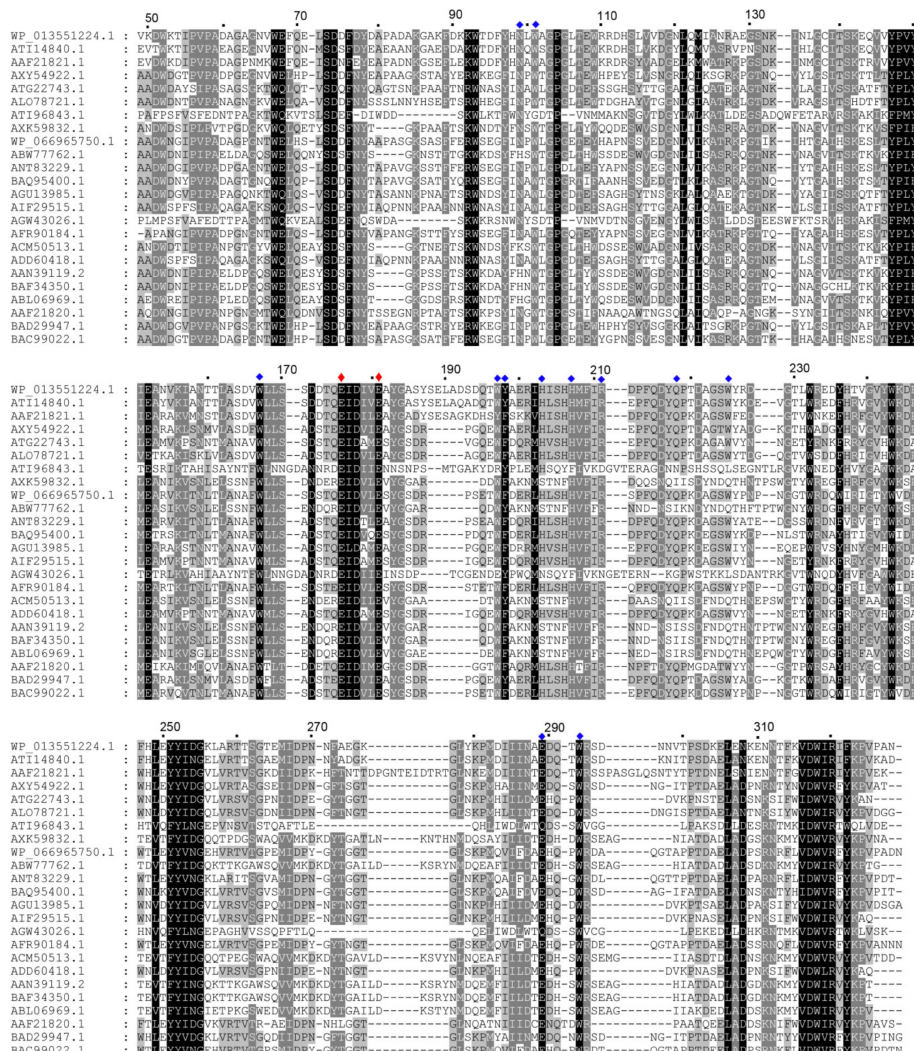
Figure 1. Multiple sequence alignment of GH16 domains of the characterized β -agarases. The alignment of amino acid sequences was carried out using Clustal Omega. The conserved and semi-conserved amino acids are shown in black and gray backgrounds, respectively. The amino acid numbering refers to the sequence of Ca Aga1. GenBank accession numbers—WP_013551224.1 for Ca Aga1 from Cellulophaga algicola DSM 14237, ATI14840.1 for Aga2 from Cellulophaga omnivescoria W5C, AAF21821.1 for Zg AgaB from Zobellia galactanivorans , AXY54922.1 for N3-1 from Microbulbifer sp. BN3, ATG22743.1 for